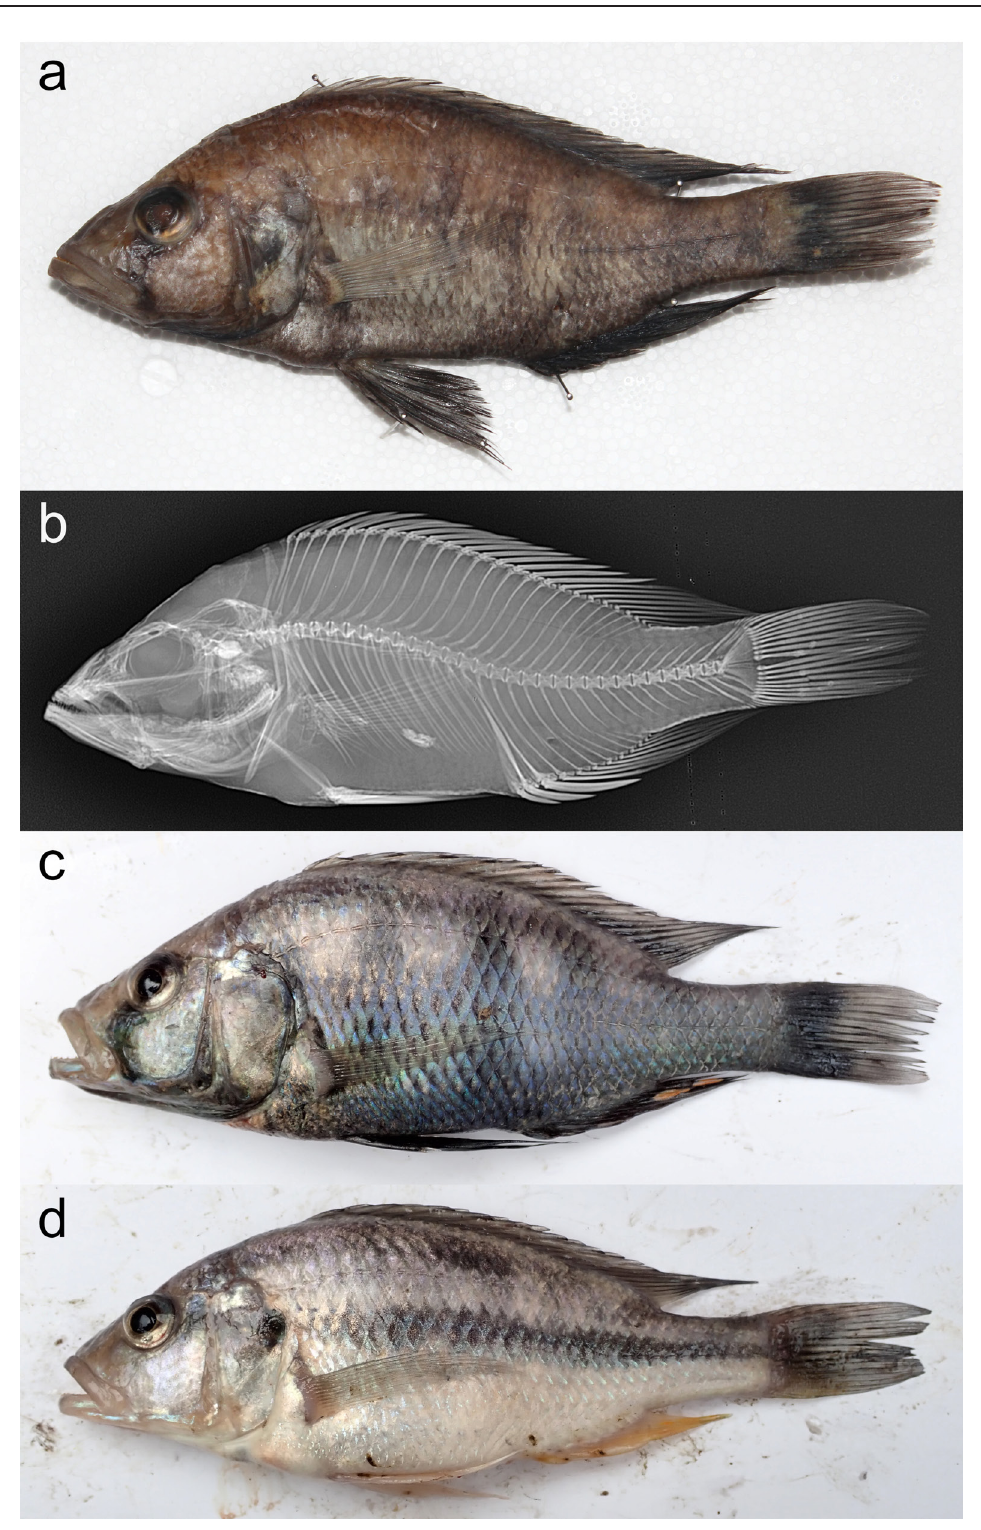
Fig. 36. Haplochromis quasimodo sp. nov. a . Photograph of preserved holotype (RMCA 2018.008.P.0336; 120.4 mm SL). b . X-ray image of holotype. c – d . Photographs of freshly caught specimens. c . Dominant male (RMCA 2018.008.P(HP3072); 123.7 mm SL). d . Female (RMCA 2018.008.P(HP3064); 116.6 mm SL) to illustrate the live colour patterns. The contrast was slightly